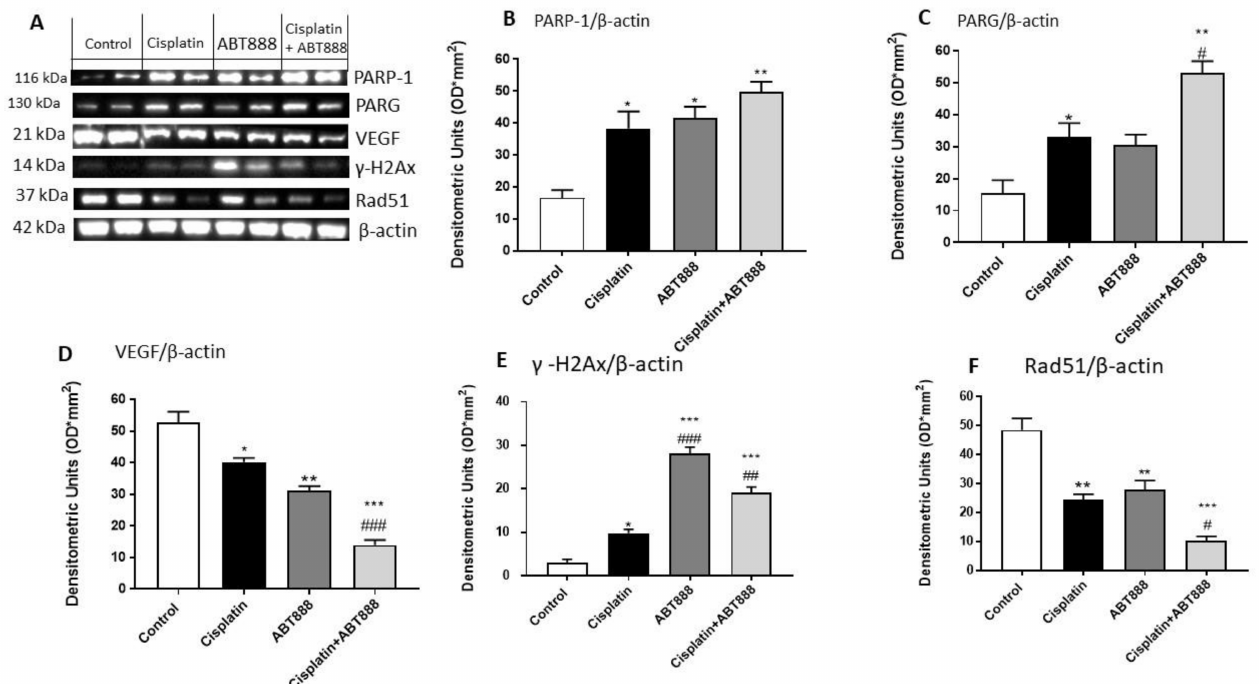
Figure 6. Effect of ABT888 and cisplatin on PARP-1, PARG, VEGF, γ -H2AX and RAD51 expression. The blots re- vealed an upregulation of PARP-1 and PARG expression in the combination group of ABT888 and cisplatin, as shown in Figures A , B and C , respectively, compared to the single treatments and control group. On the contrary, the expression of VEGF, γ -H2AX and RAD51 were significantly reduced in the combinatory treatment of ABT888 and cisplatin, compared to control group, as shown in Figures D , E and F , respectively. Data are representative of at least three independent experiments. ( B ) * p < 0.05, ** p < 0.01, vs. the control. ( C ) * p < 0.05, ** p < 0.01, vs. the control; # p < 0.05 vs. cisplatin group. ( D ) * p < 0.05, ** p < 0.01, *** p < 0.001 vs. the control; ### p < 0.001 vs. cisplatin group. ( E ) * p < 0.05, *** p < 0.001 vs. the control; ## p < 0.01, ### p < 0.001 vs. cisplatin group. ( F ) ** p < 0.01, *** p < 0.001 vs. the control; # p < 0.05 vs. cisplatin